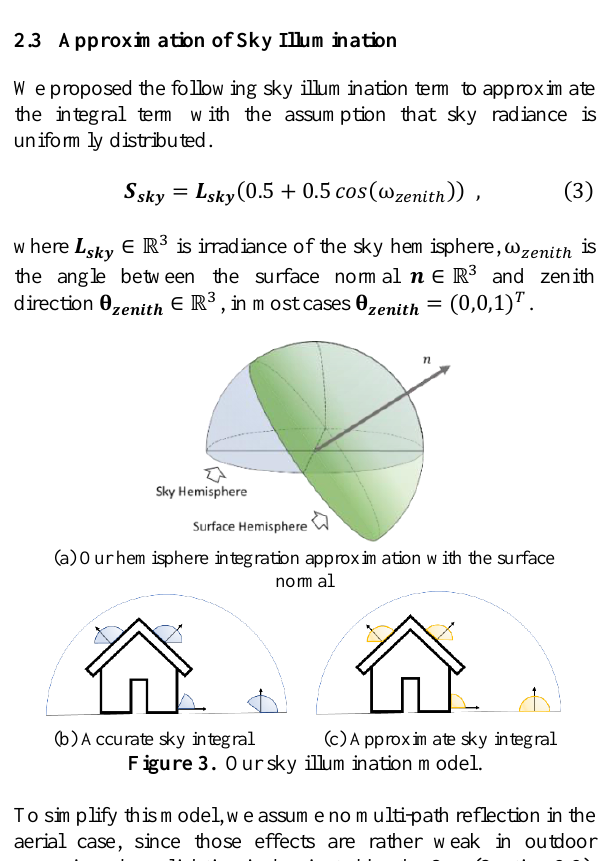
Figure 2. Evaluate the impact of indirect illumination, the PSNR for image (a) with (b) as the reference is 76.75dB.